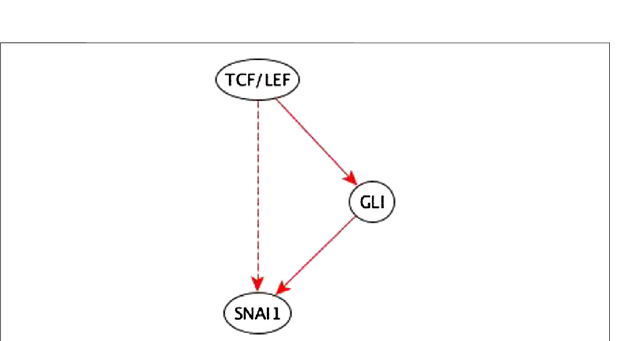
FIGURE7| Exampleofindirectregulatorswiththeinferredcausallogicimplicationre fl ectedinapath. (A) .SLAC1isinferredtobeanecessaryregulatorofClosure, which is re fl ected by the necessary path formed by SLAC1, AnionEM, H 2 O Ef fl ux, and Closure. Hence the dashed edge from SLAC1 to Closure is not added to the network. (B) NOGC1 is inferred to be a necessary regulator of 8-nitro-cGMP, which is re fl ected by the necessary path formed by NOGC1, cGMP, and 8-nitro-cGMP. Hence the dashed edge from NOGC1 to 8-nitro-cGMP is not added to the network.